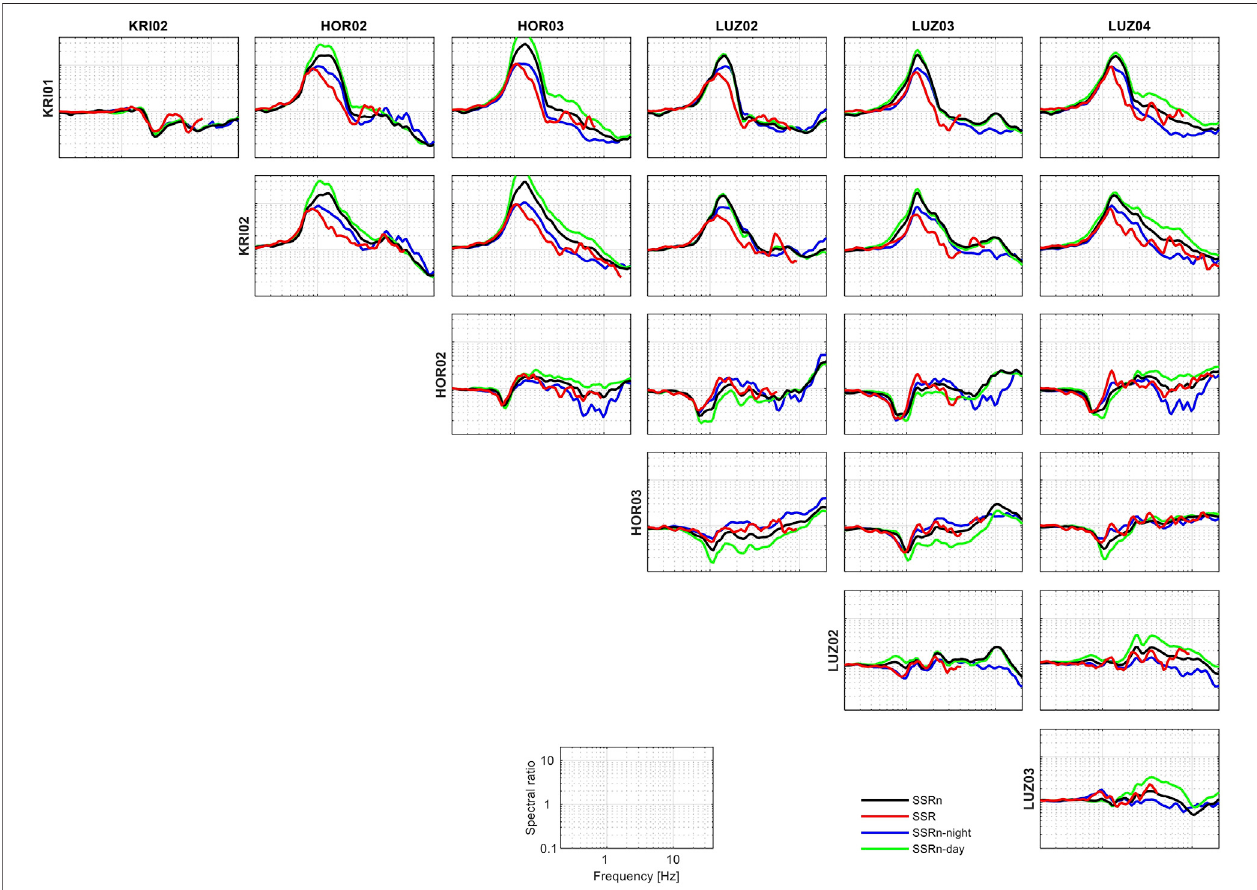
FIGURE 12 | Comparison between SSR and SSRn for all combinations of stations located inside the sedimentary basin. The SSRn is a mean over 7 days, respectively, considering the whole day (black), the night between 00:00 – 3:00 UTC (blue), and the day between 08:00 – 11:00 UTC (green).